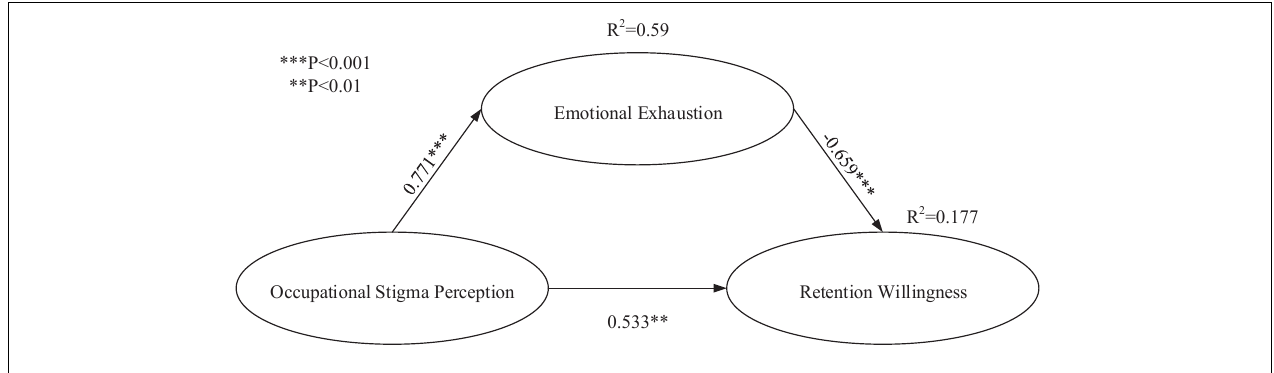
FIGURE 3 | Results of the structural model.